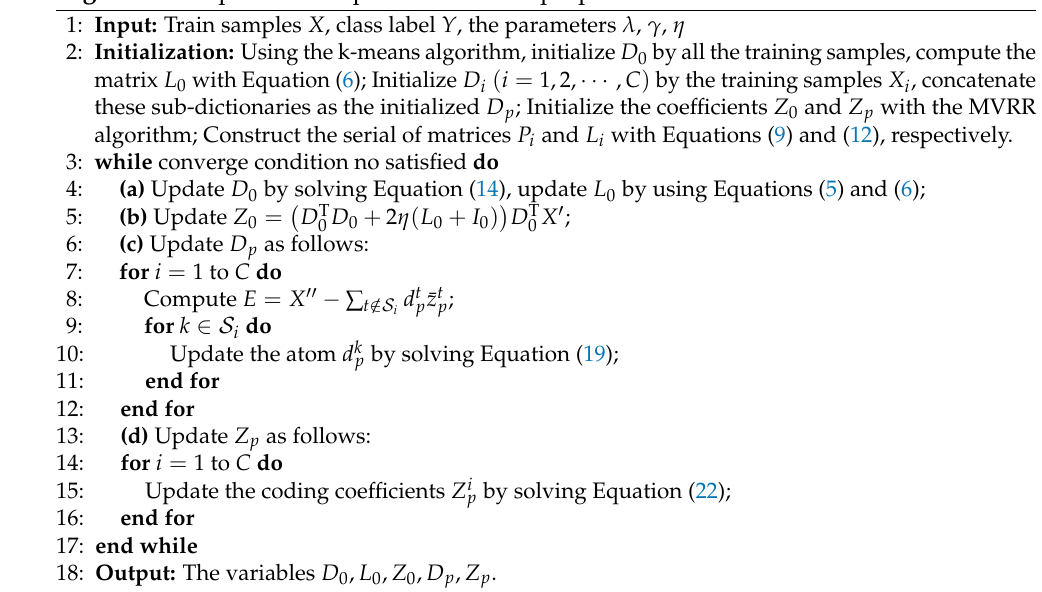
Algorithm 1 Optimization procedure of the proposed